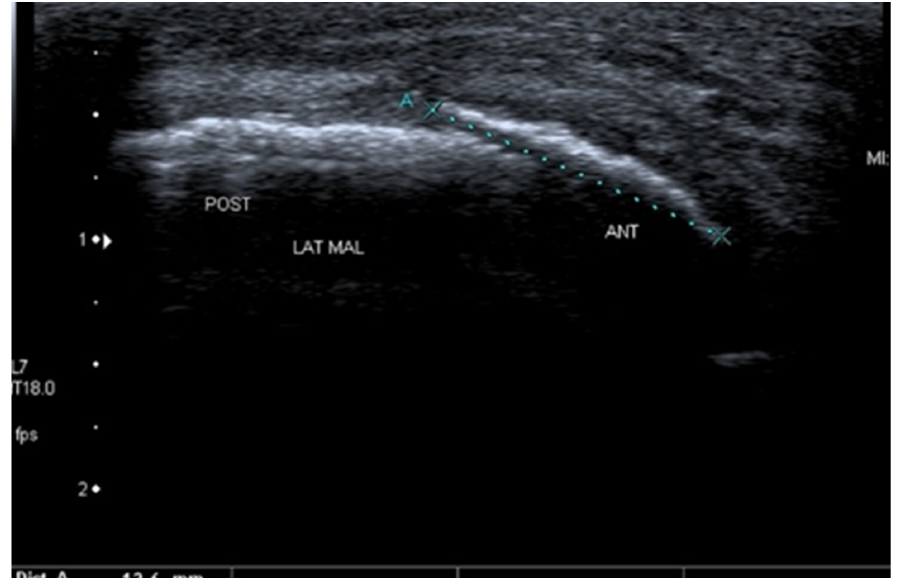
Figure 12. Avulsion of the proximal attachment of the anterior talofibular ligament (ATFL). The dotted line A marks the avulsed and anteriorly displaced fragment of the lateral malleolus (LM). POST—posterior; ANT—anterior part of the ankle. Probe positioned along course of the ATFL. Linear probe 7–18 MHz.